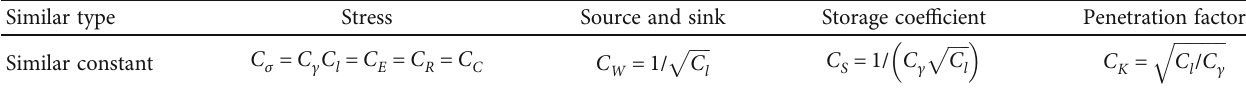
Table 1: The main similarity relationship between the prototype and the model of fl uid-structure interaction similar materials. Similar type